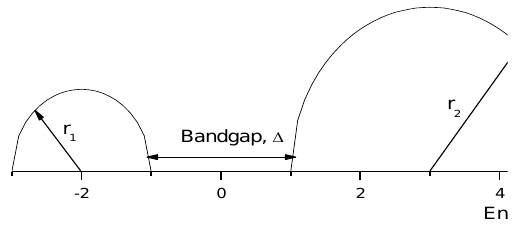
Figure 2. Schematic drawing of the semicircular band used in the calculation of the sample DOS showing the band gap ∆ around the Fermi level, E